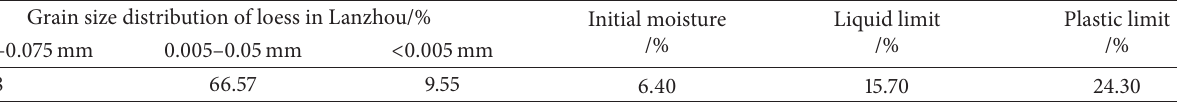
Table 1: Grain size distribution and physical properties of frozen